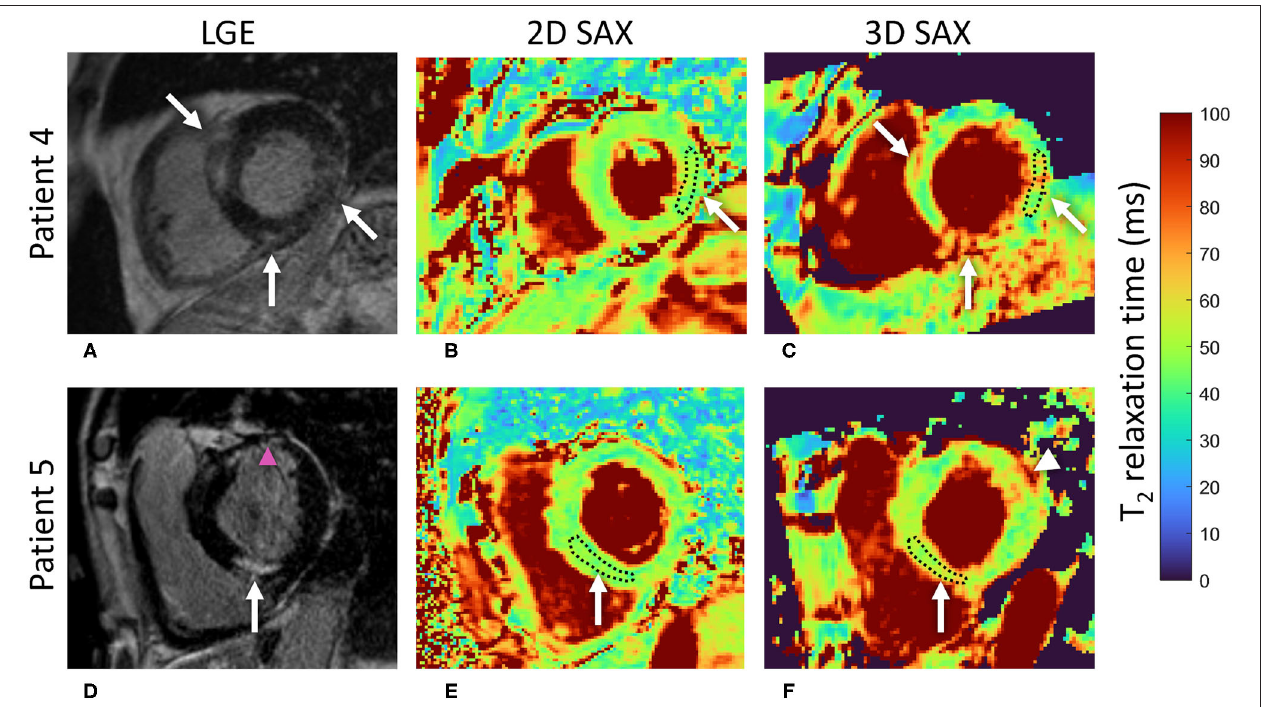
FIGURE 7 | A comparison of the 2D and 3D T 2 mapping techniques in slices with lesions detected with LGE imaging. (A) LGE shows intramyocardial areas of irreversible damage in several basal regions of the LV in a 56 y.o. male patient with suspected cardiac sarcoidosis. (B) No T 2 elevation is visually apparent on the 2D T 2 map. As an example, the measured segmental ROI average T 2 in the basal inferolateral segment was 46ms. (C) Conversely, local increases of the T 2 relaxation time can be spotted on the 3D T 2 map in areas corresponding to the LGE regions (white arrows). The measured segmental ROI average T 2 in the respective inferolateral segment was 56ms, suggestive of an area of acute injury or ongoing inflammation. (D) An intramyocardial area of irreversible damage as shown by LGE (left, white arrow) in the basal inferoseptal segment of the LV in a 66 y.o. male patient with suspected cardiac sarcoidosis. The pink arrowhead indicates an ischemic scar in the anterior wall. (E) Again, no T 2 elevation was visually apparent on the 2D T 2 map in the respective segment with the segmental ROI average T 2 = 47ms. (F) Local (white arrow) increase of the T 2 relaxation time (segmental ROI average T 2 = 55ms) can be spotted in this region on the 3D T 2 map, suggestive of an area of acute injury. White arrowhead points to another area of elevated T 2 that does not correspond to any LGE in (D) . The institutional reference range for 2D T 2 mapping is 44 (2.4) ms, i.e., 39–49ms. LGE, late gadolinium enhancement; LV, left ventricle; ROI, region of